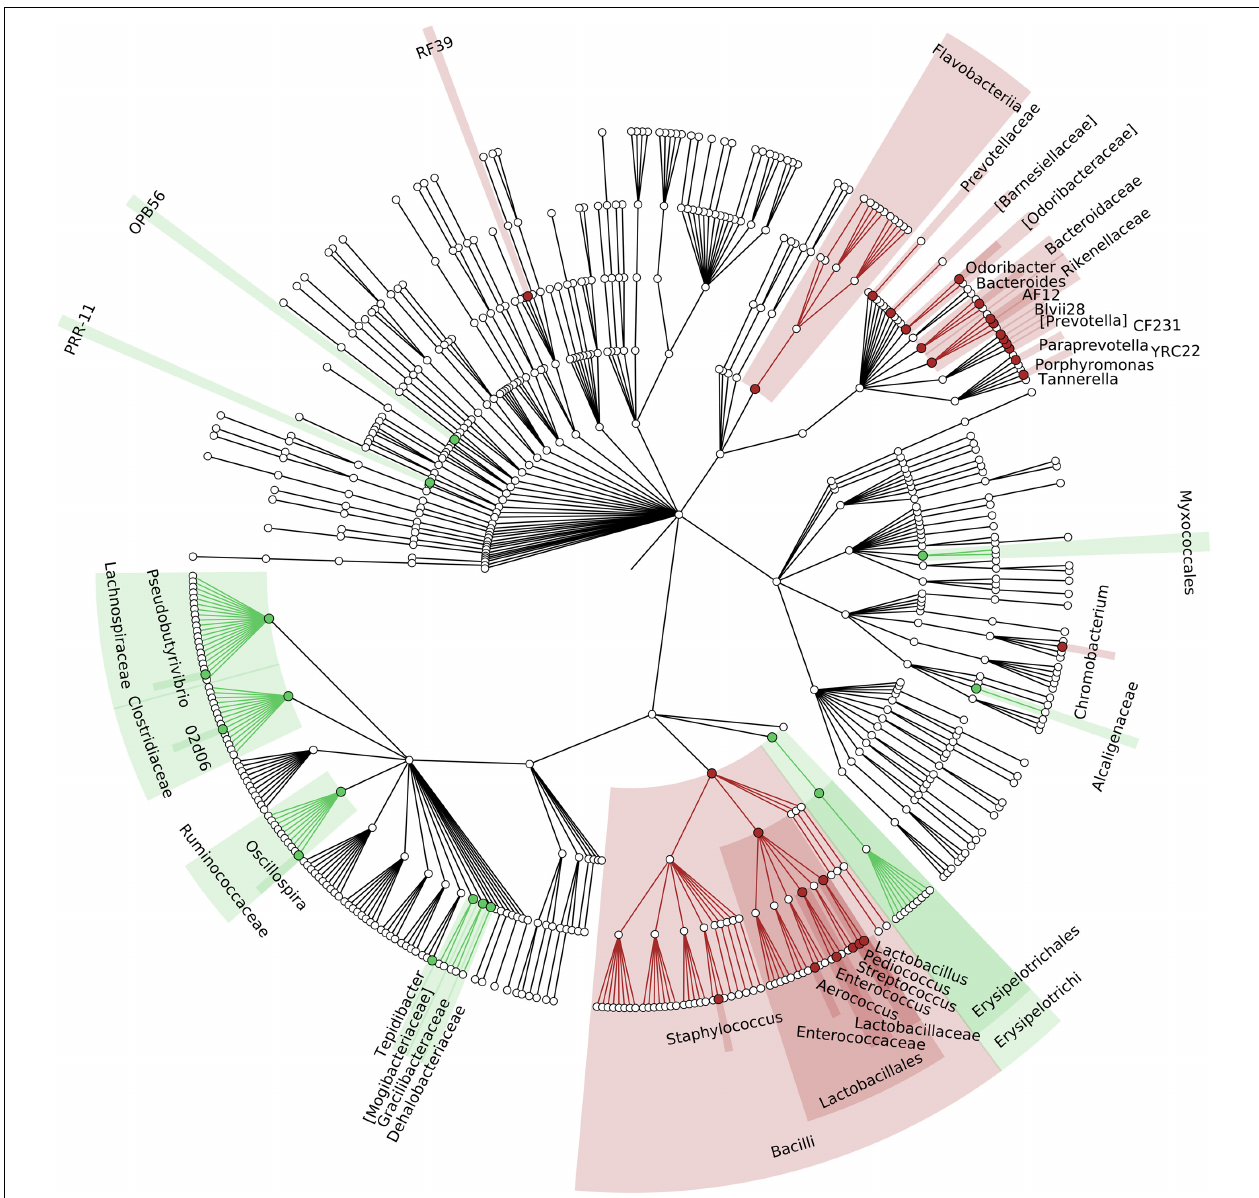
FIGURE 1 | Cladogram illustrating the distribution of taxa with differential abundance between cecal contents (CCs) and feces, according to 16S-MG data. Each dot represents an identified taxon, with taxa higher in CCs colored in green, and those higher in feces in brown.